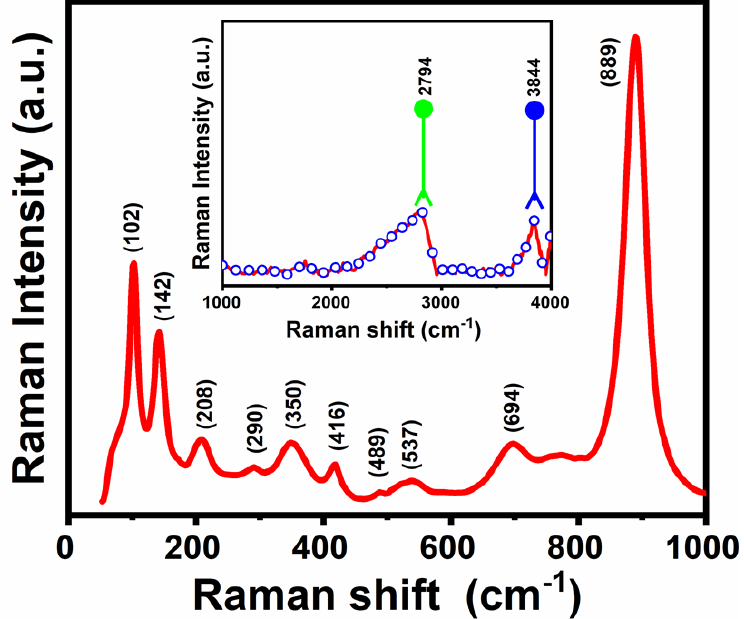
Figure 3. Raman spectrum of the calcined Ni-CoWO 4 NPs.